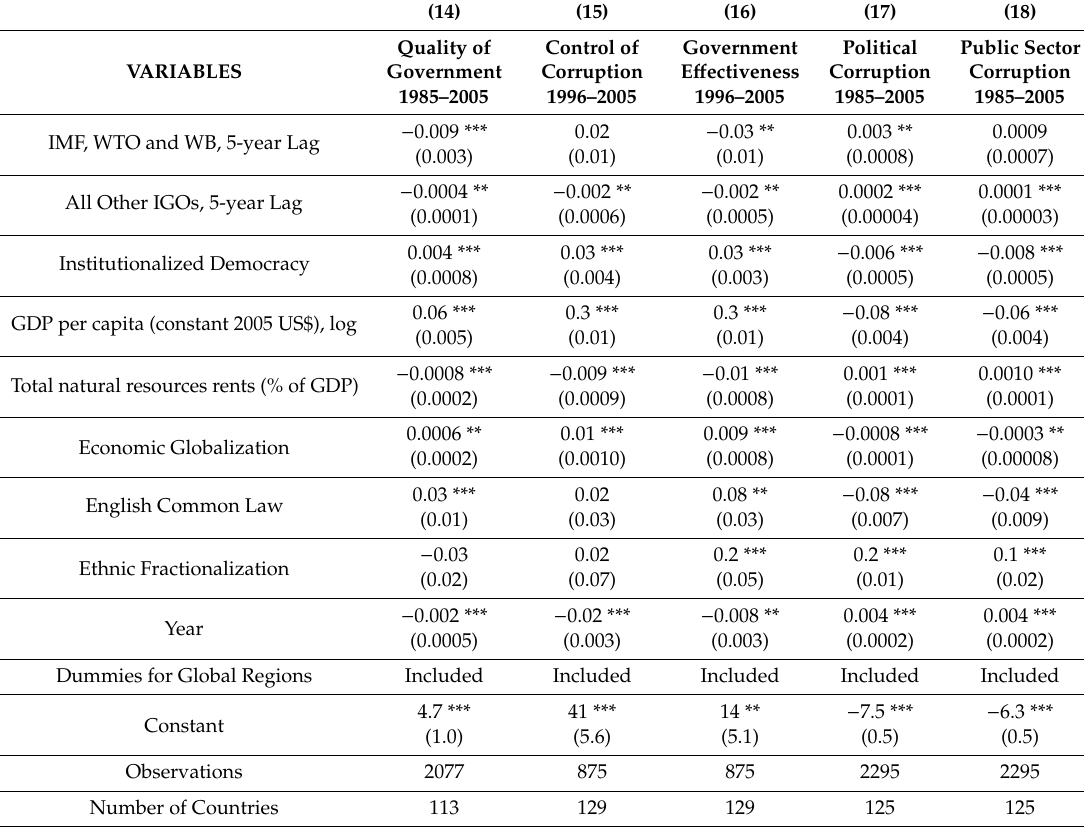
Table 4. Separating membership in the International Monetary Fund (IMF), World Trade Organization (WTO), and World Bank (WB) from all other IGOs: GLS AR(1), cross-section time-series